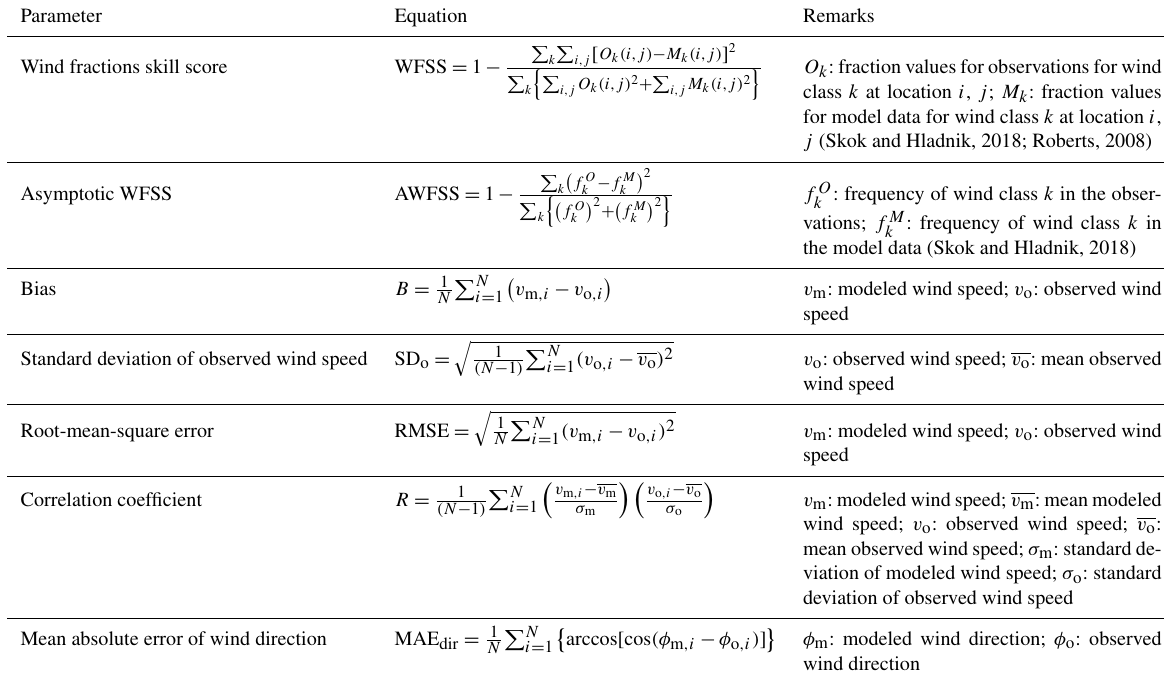
Table 3. Statistical performance parameters used for the intercomparison of the wind field modeling results. Parameter